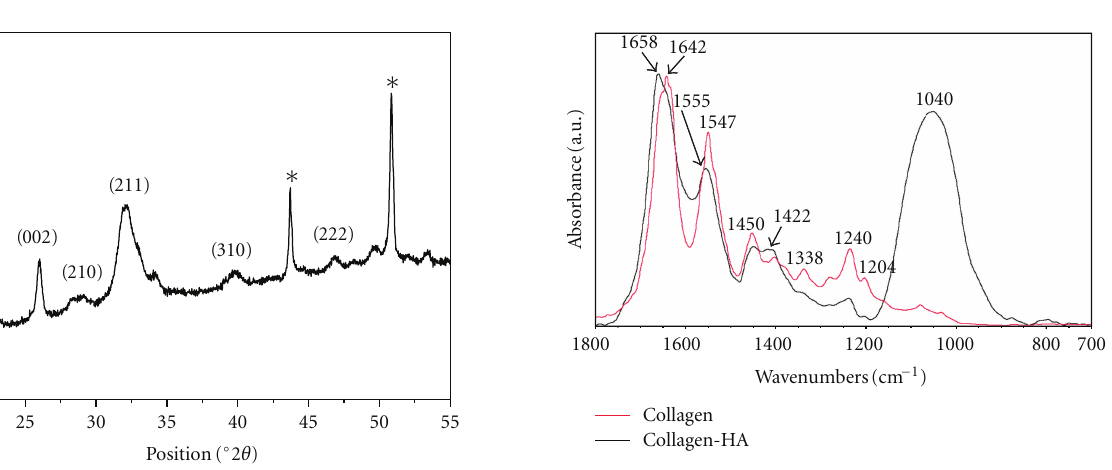
Figure 5: X-Ray di ff raction (XRD) pattern of collagen-hydrox- yapatite composite; ∗ indicates the Ti alloy di ff raction peaks.